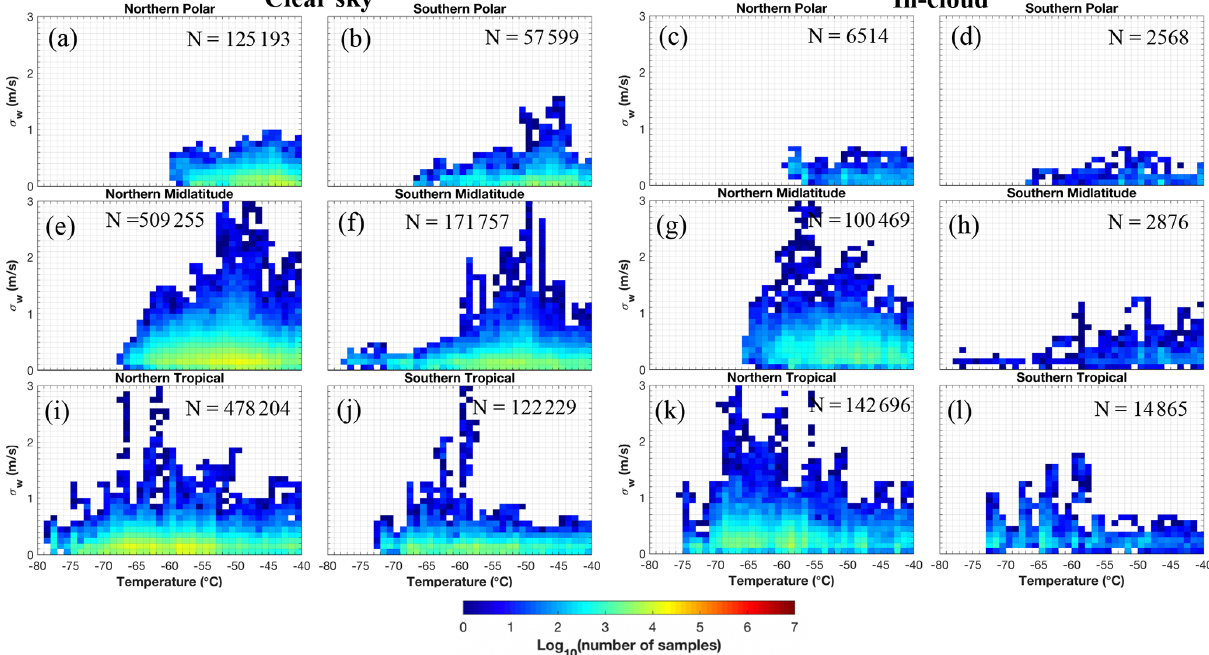
Figure 9. Distributions of σ w calculated for every 40s using the 1Hz observations under (two left columns) clear-sky and (two right columns) in-cloud